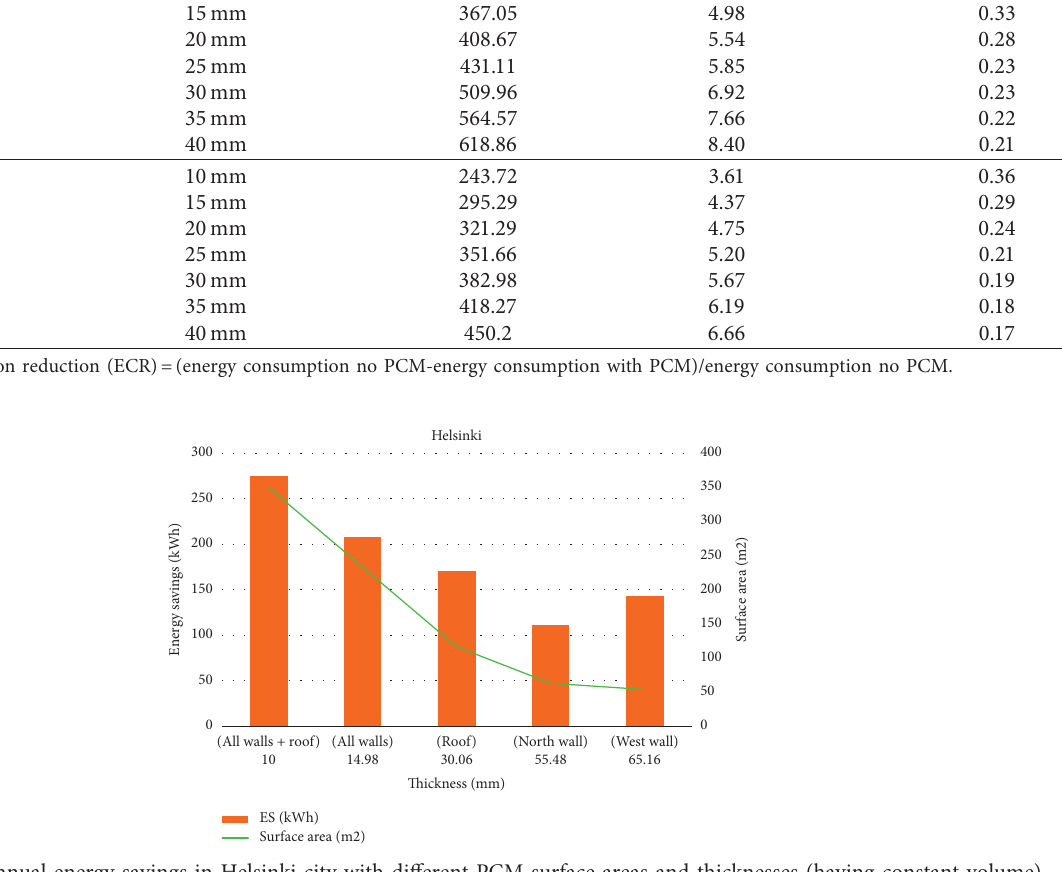
Figure 13: Annual energy savings in Helsinki city with different PCM surface areas and thicknesses (having constant